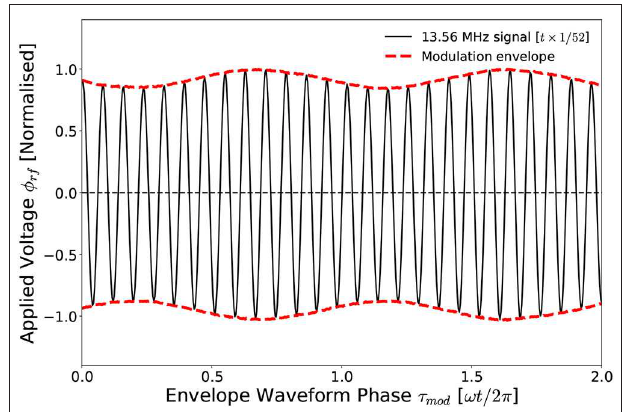
FIGURE 5 | Example of rf amplitude modulation where the base frequency of ν rf = 13.56 MHz is modulated at ν mod = 8 kHz by a modulation fraction of φ mod = 0.16. For clarity the 13.56 MHz signal is plotted at τ rf = 1 temporal